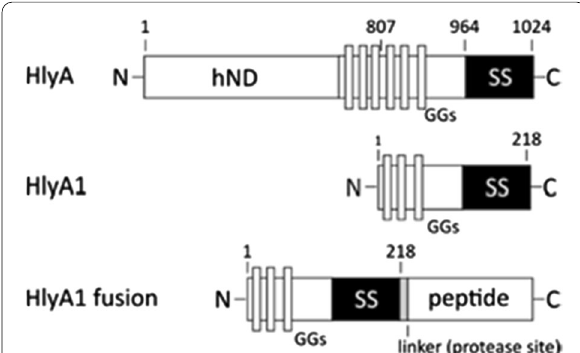
Fig. 1 Schematic view of HlyA, HlyA1 and a HlyA1 fusion. HlyA consist of a hydrophobic N‑terminal domain (hND), an RTX domain (RTX) characterized by the presence of so‑called GG repeats (GGs) and a C terminal secretion signal (SS, ~ 60 aa). In HlyA1 and HlyA1 fusions the C‑terminal 218 aa of HlyA are present. Between HlyA1 and fused targets a Tobacco Edge Virus (TEV) cleavage site is inserted. Numbers indicate the position in the corresponding amino acid